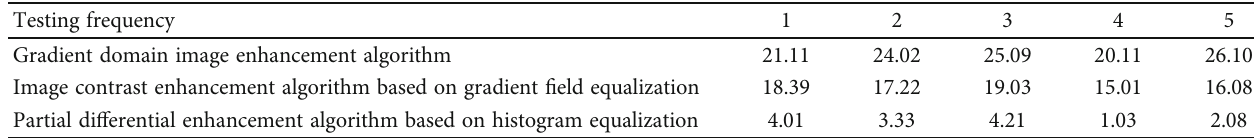
Figure 8: Comparison of image information entropy values under di ff erent fractional di ff erential Table 1: Comparison table of enhanced algorithm running time (unit: s).